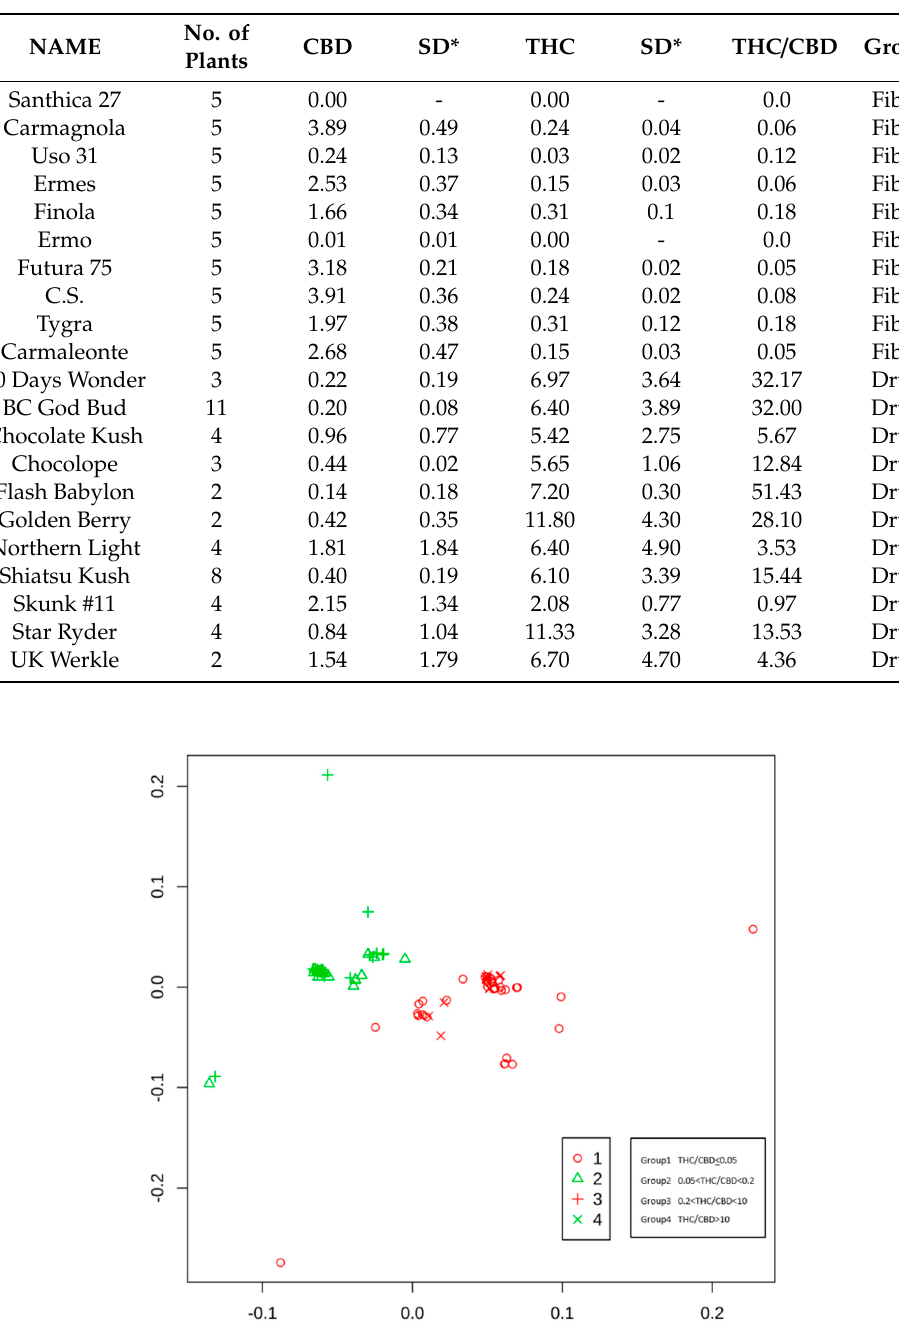
Table 1. The main cannabinoid contents of the plants from the experimental cultivations collected at the mature stage. The values are expressed as a percentage of inflorescence dry weight. * SD = standars deviation.